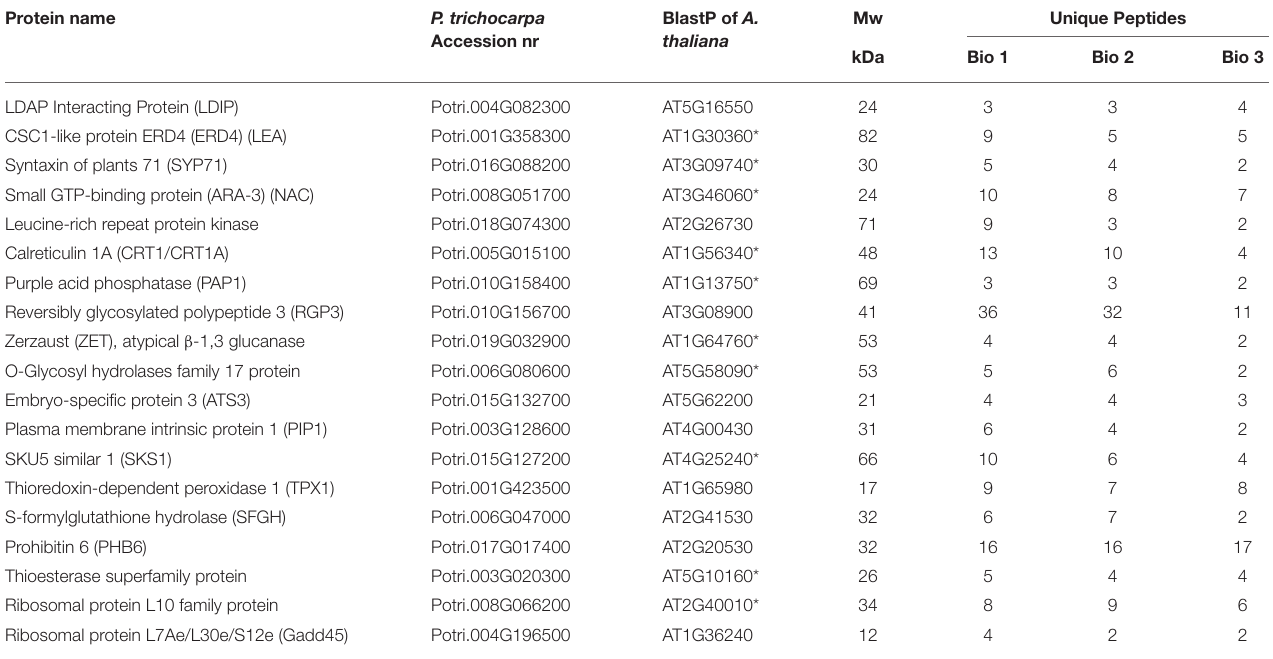
TABLE 2 | Proteins that are shared by the bud LB fraction of Populus and the PD-enriched fraction of Populus trichocarpa Leijon et al.